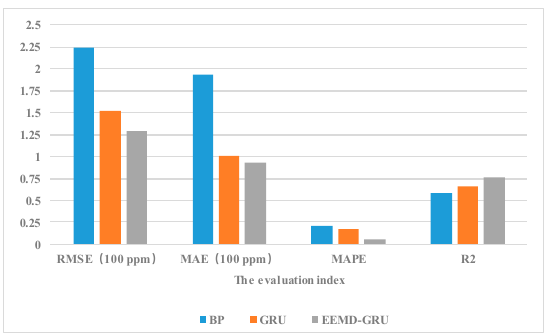
Figure 11. Comparison of prediction errors during spring and summer.